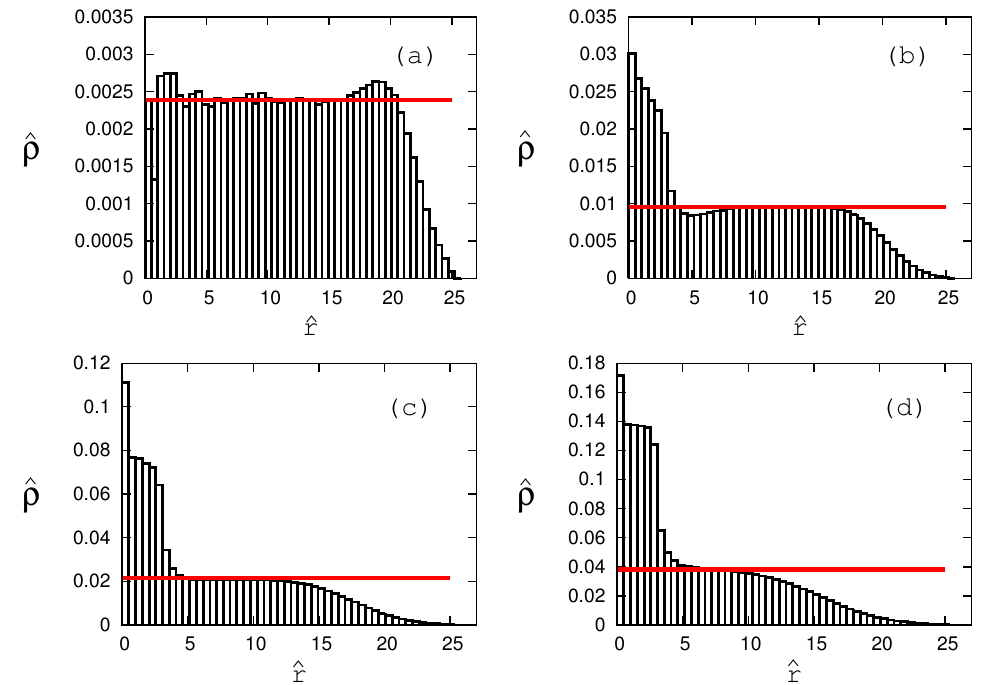
Figure 4. Ion densities ˆ ρ as a function of distance ˆ r from the trap’s center (histograms) for four different trap parameters, that is, q = 0.1 ( a ), q = 0.2 ( b ), q = 0.3 ( c ), and q = 0.4 ( d ) at their respective loading rates λ max (see Figure 3). The red, horizontal line is the pseudo-potential prediction for ˆ ρ . We see that the pseudopotential predicts the density approximately only for q = 0.1, while significant deviations from the pseudo-potential prediction are observed for q >